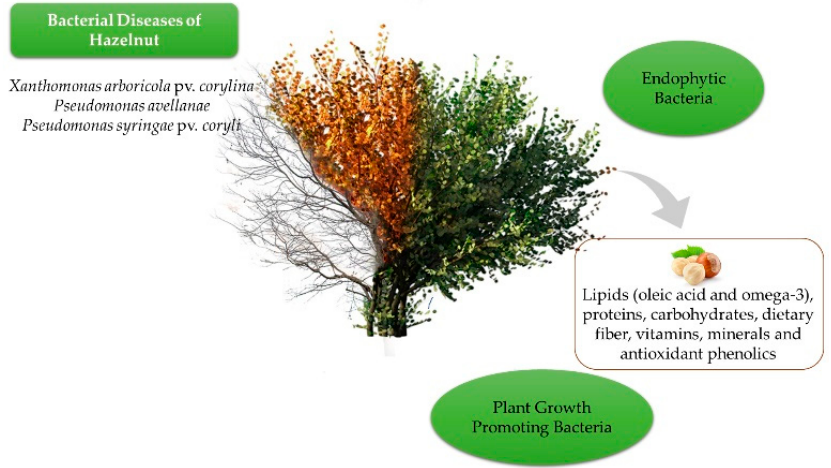
Figure 1. The multifaceted interaction between hazelnut and